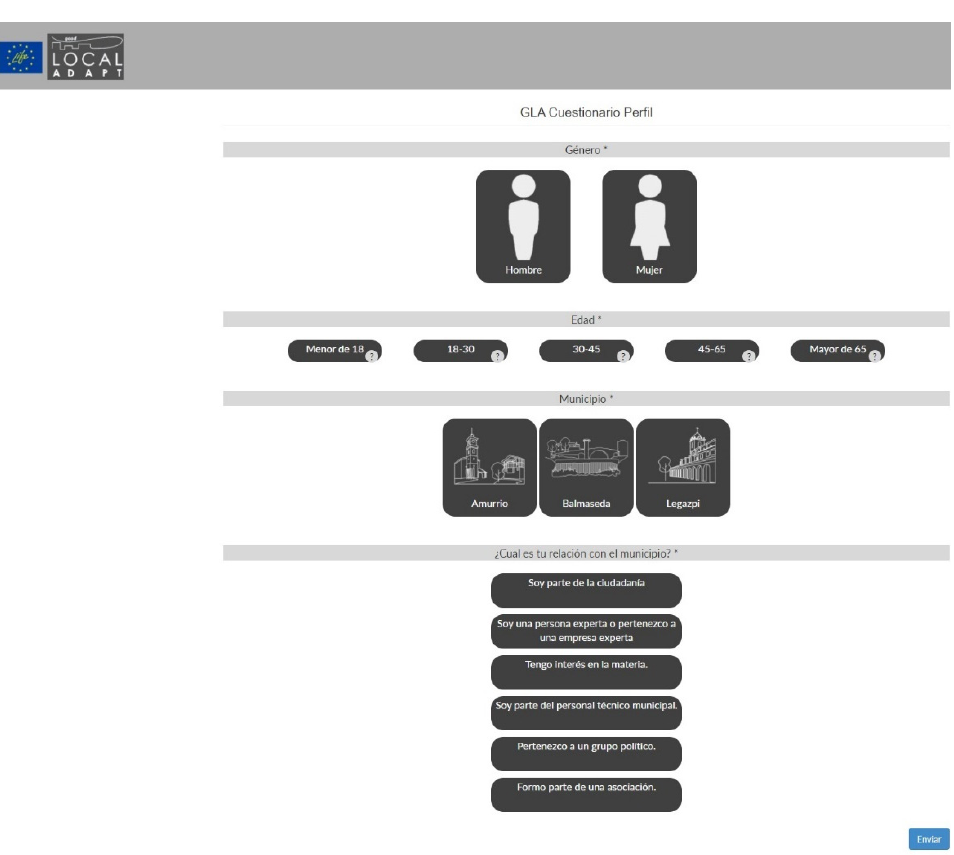
Figure 6. Screenshot of the on ‐ line platform (Citizen): participants’ profile.